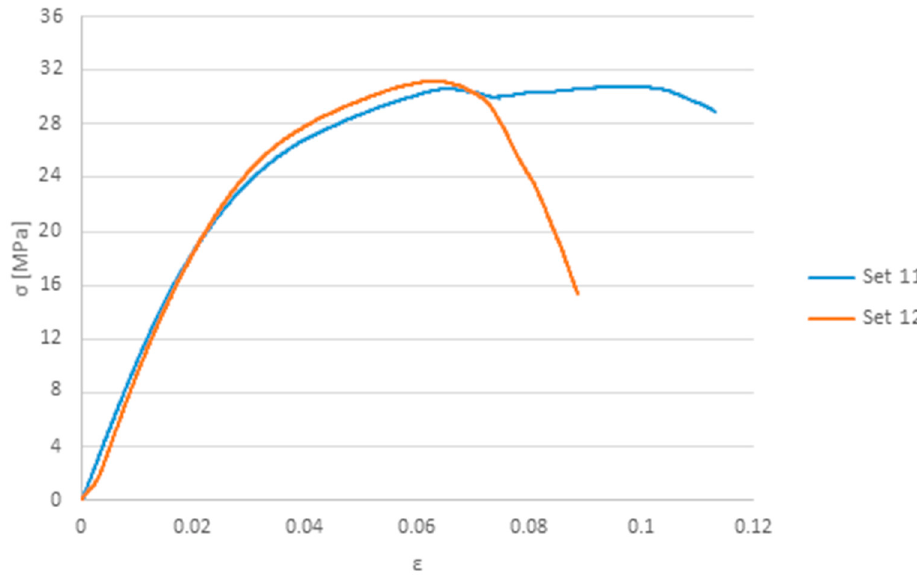
Figure 9. Stress-strain curve obtained for samples welded with sets 11 and 12.